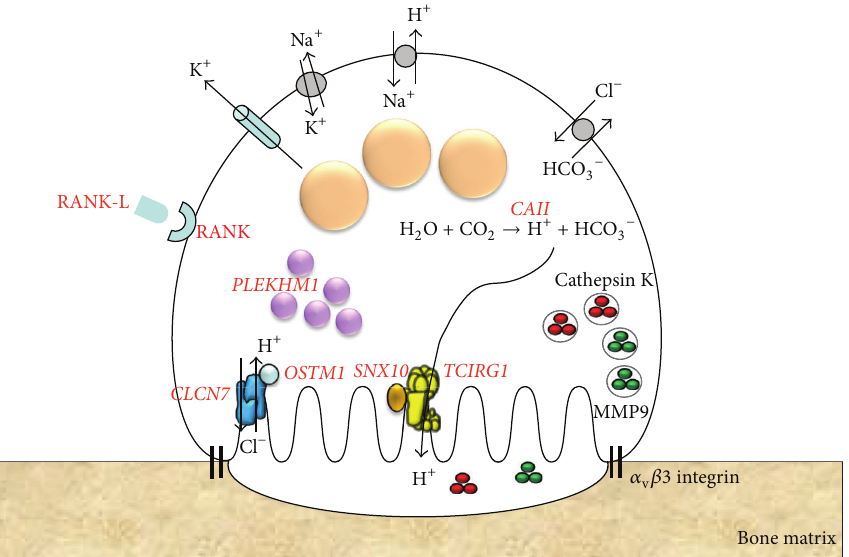
Figure 1: Schematic diagram showing an osteoclast and the involved genes in osteopetrosis. Cellular localization and protein involved in osteoclast differentiation and function. The genes mutated in human osteopetrosis are red in bold.